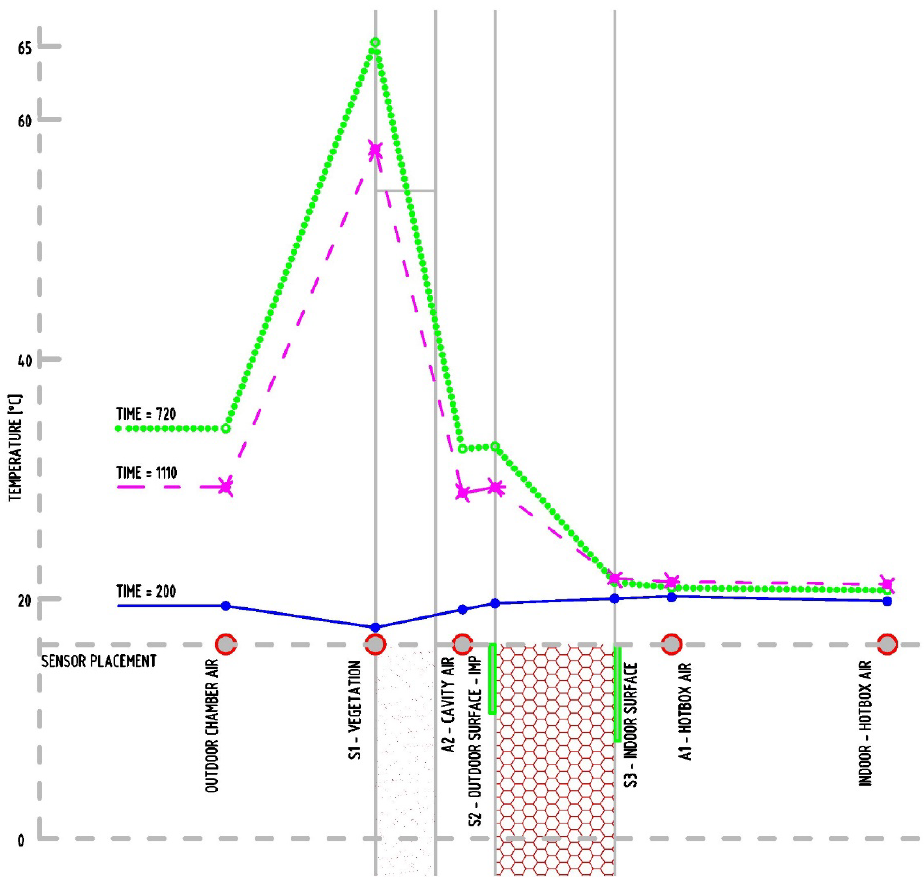
Figure 10. Measurement with VB and without watering (courses in Figure 6). Measured temperatures for analyzed positions for times: 200 min after start of measurement; 720 min–highest temperature on the VB; 1110 min, just after turning off the SS.